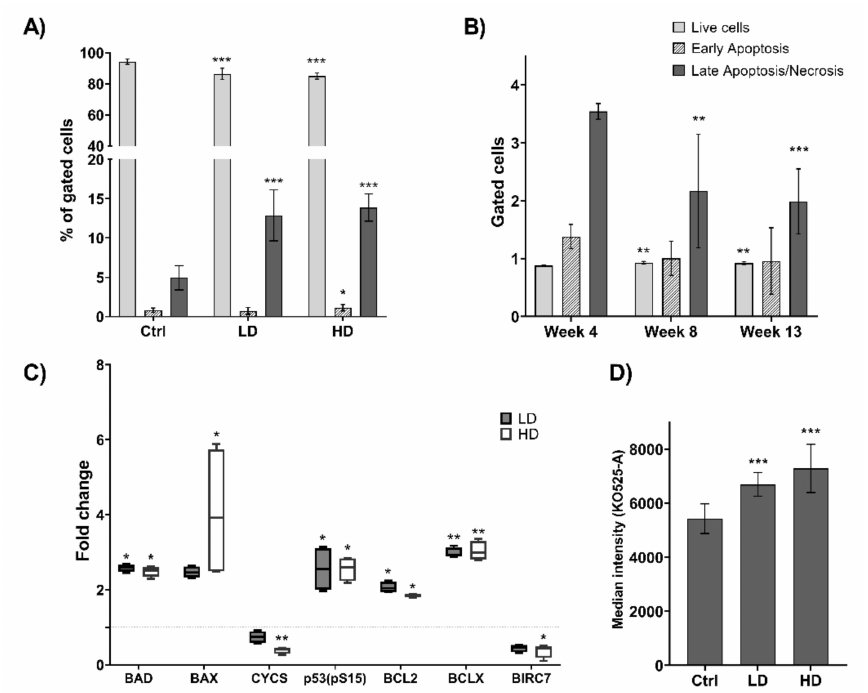
Figure 3. Effects of TiO 2 exposure on cell death pathways. Effects on apoptosis and autophagy were analyzed after 4, 8 and 13 weeks of exposure to TiO 2 . Apoptosis was measured by flow cytometry using Annexin V and PI staining and illustrated as ( A ) percentage of gated cells of merged data from all weeks, compared to Ctrl, and ( B ) merged LD and HD data shown as the number of gated cells normalized to Ctrl, compared to week 4. ( C ) Data illustrate fold changes in the expression of apoptotic proteins measured after 13 weeks of exposure, compared to Ctrl. ( D ) Autophagy was measured by flow cytometry. Changes in autophagic vacuoles are illustrated as alterations in median fluorescent intensities. Data represent merged data of all weeks. Control (Ctrl), low dose (LD): 0.96 µ g/cm 2 and high dose (HD): 1.92 µ g/cm 2 . Data indicate mean ± SEM, ( n = 6 ( A , D ), n = 4 ( B , C )). * p < 0.05, ** p < 0.01, *** p < 0.001 (Linear regression and linear mixed